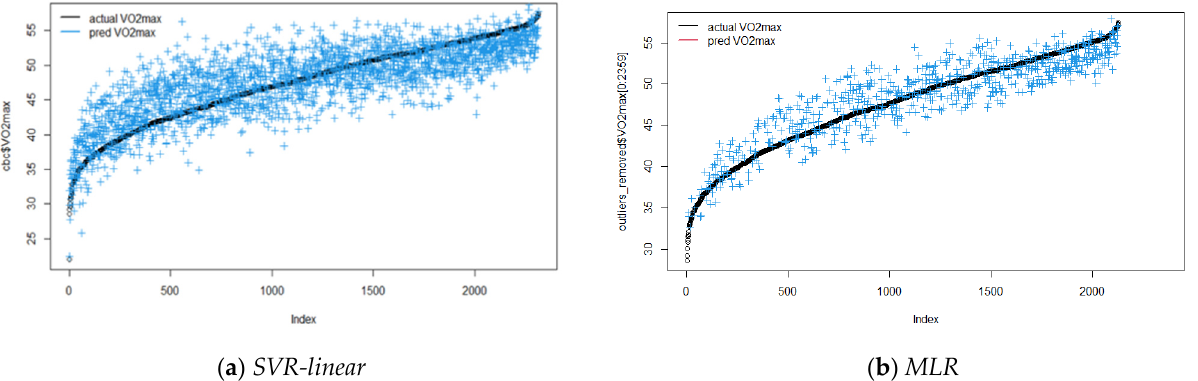
Figure 6. Scatterplots for actual and predicted values using SVR-linear ( a ) and MLR ( b ) for boys (tuned model).